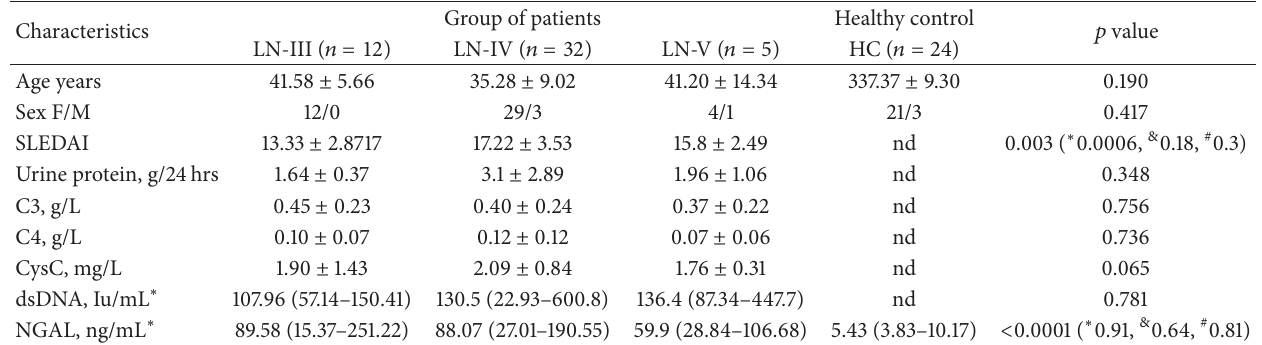
Table 1: Baseline demographic and laboratory